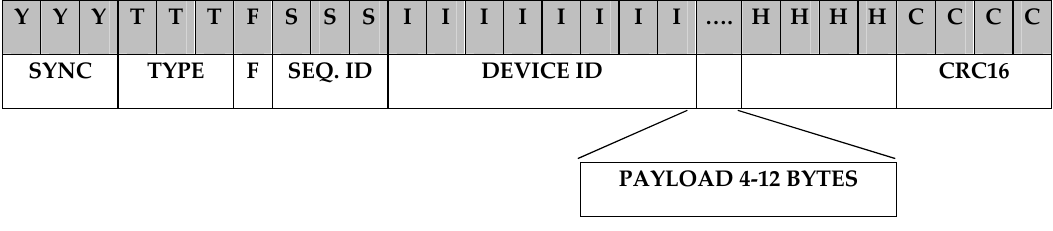
Figure 14. Download message structure in SIGFOX. The operating time can vary from 0 to 2048. This time applies equally to all nodes, acting on those selected valves by assigning “1” to the corresponding bit. The information sent by the MKR1200 module reaches the backend, a SIGFOX web application where users can visualize the data in a hexadecimal format list. The information must be sent in real